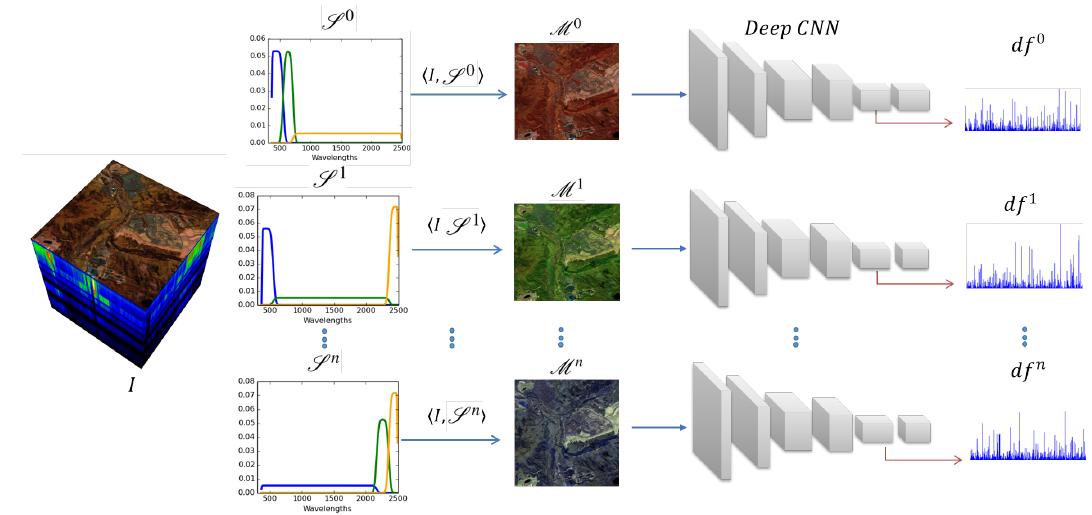
Figure 1. Block diagram of the proposed